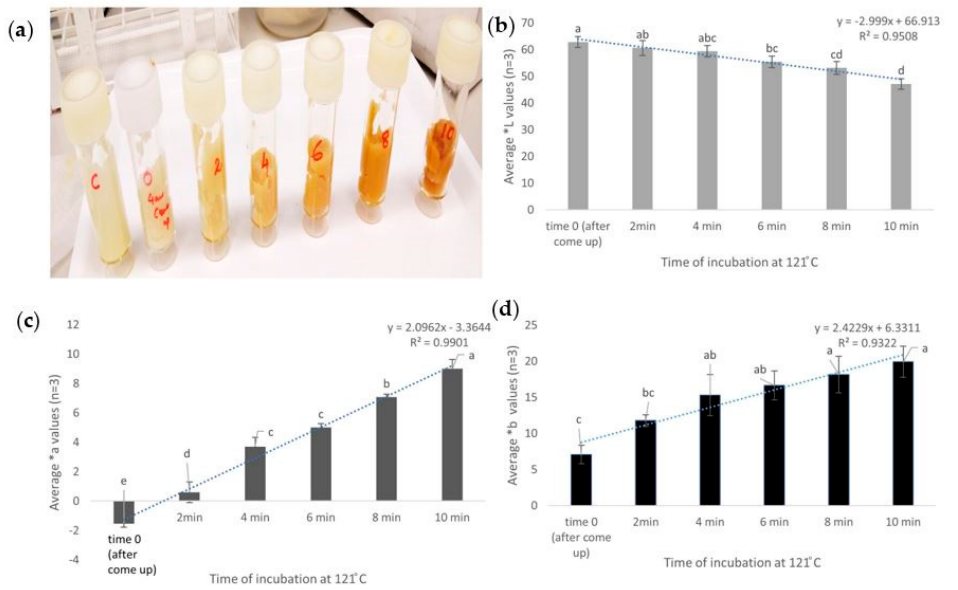
Figure 6. Mashed potato samples with M2 after exposure up to 10 min at 121 °C. The visual change in color ( a ), change in *L values ( b ), change in *a values ( c ), and change in *B values ( d ). The similar letters in each graph indicate no significant difference ( p < 0.05).